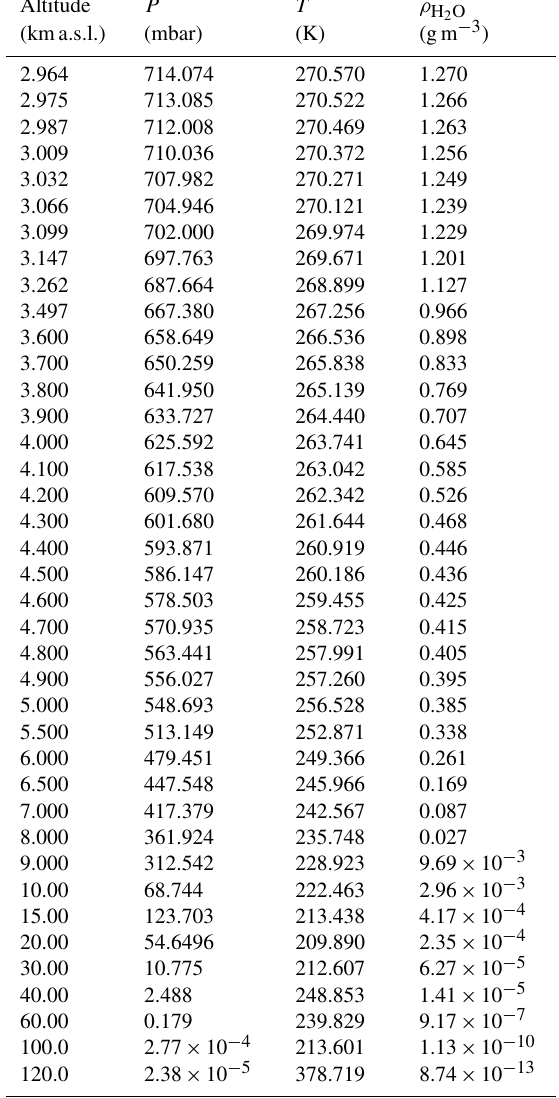
Table A1. Mean atmospheric state of the closure data set: pressure, temperature, and water vapor density profiles. The data set was se- lected from Zugspitze solar FTIR spectra measured from Decem- ber 2013 to February 2014 and contains 52 spectra. Spectra selec- tion criteria are listed in Sect. 3.3. Altitude P T